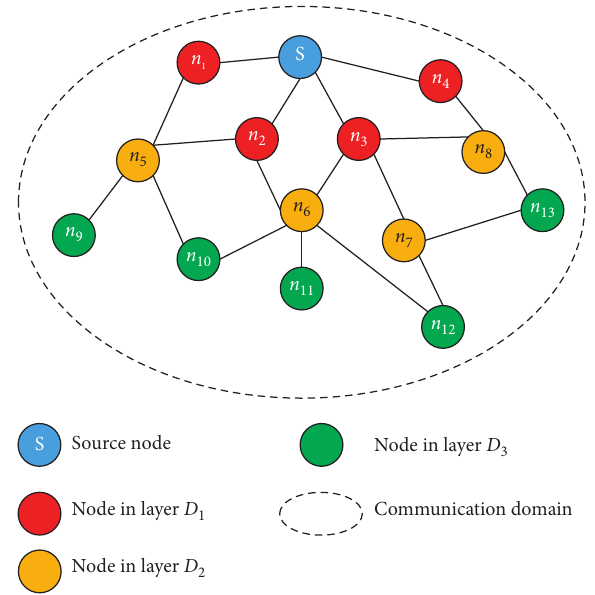
Figure 5: Node hierarchy